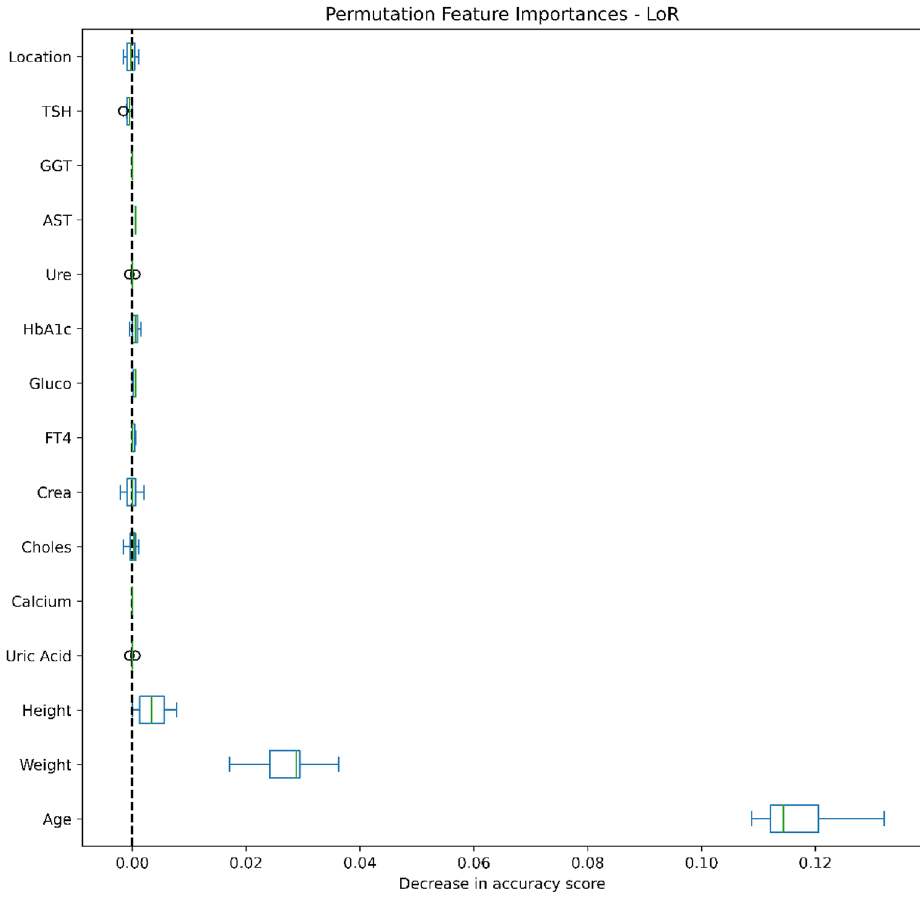
Figure 5. Feature importance for LoR in the second